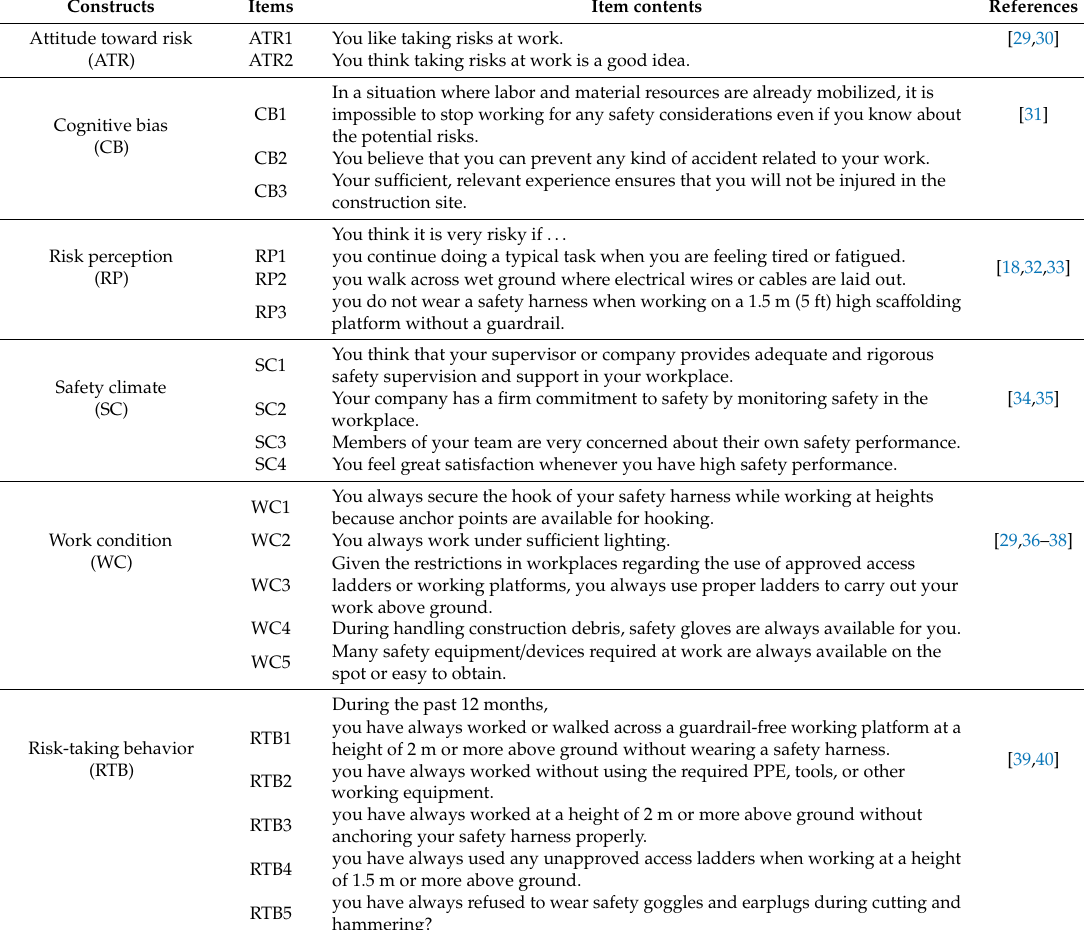
Table 1. Item contents of the constructs in the proposed